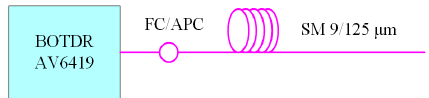
Figure 6. The schematic diagram of Brillouin gain spectrum measurement for a single-mode fiber. The sampling resolution and the frequency scanning interval are set to 0.1 m and 1 MHz, respectively. The wavelength of the incident light is 1550 nm. The pulse width is set to a value ranging from 10 ns to 200 ns. The frequency scanning ranges from 10.52 GHz to 10.92 GHz. The average number of waveforms is 2 18 . The SNR of the measured spectra ranges from 32.76 dB to 35.84 dB. These signals are spectra with high SNR. For any pulse width, a typical set of Brillouin gain spectrum is chosen. The fitting and calculation results by the Lorentzian, Gaussian, pseudo-Voigt and Voigt profile-based algorithms are shown diagrammatically in Figure 7. The extracted g BM , v B , Δ v B , and E are included in Table 7. g BMM , v BM and Δ v BM are the mean values of the extracted g BM , v B and Δ v B , respectively. From Figure 7 it can be seen that there is a considerable difference between the curves fitted by the Lorentzian, Gaussian profile-based algorithms and the measured one whatever the pulse width is employed. Therefore, the parameters extracted by the Lorentzian, Gaussian profile-based algorithms in Table 7 may contain errors. The difference between the curves fitted by the Lorentzian increases with decreasing pulse width and at the same time, the difference between the curves fitted by the Gaussian increases with increasing pulse width which is consistent with [32].